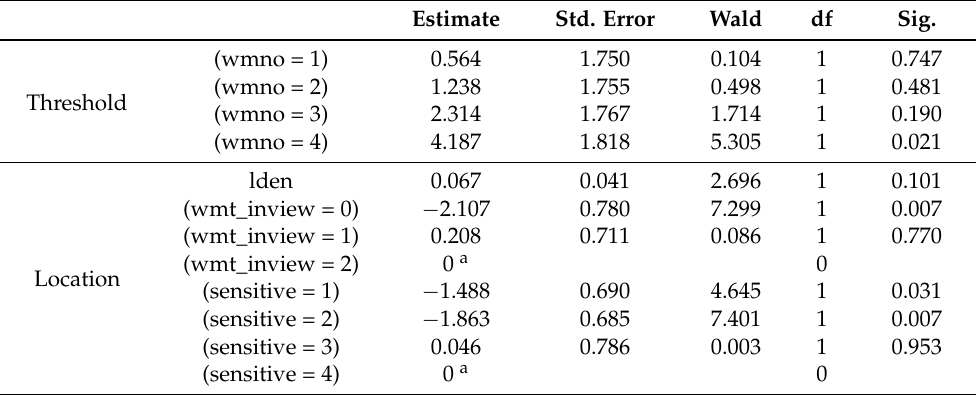
Table A4. Estimated parameters of the relationship between noise exposure (L den ) and wind turbine noise annoyance with control for sensitivity, and number of windmill turbines in view. N =